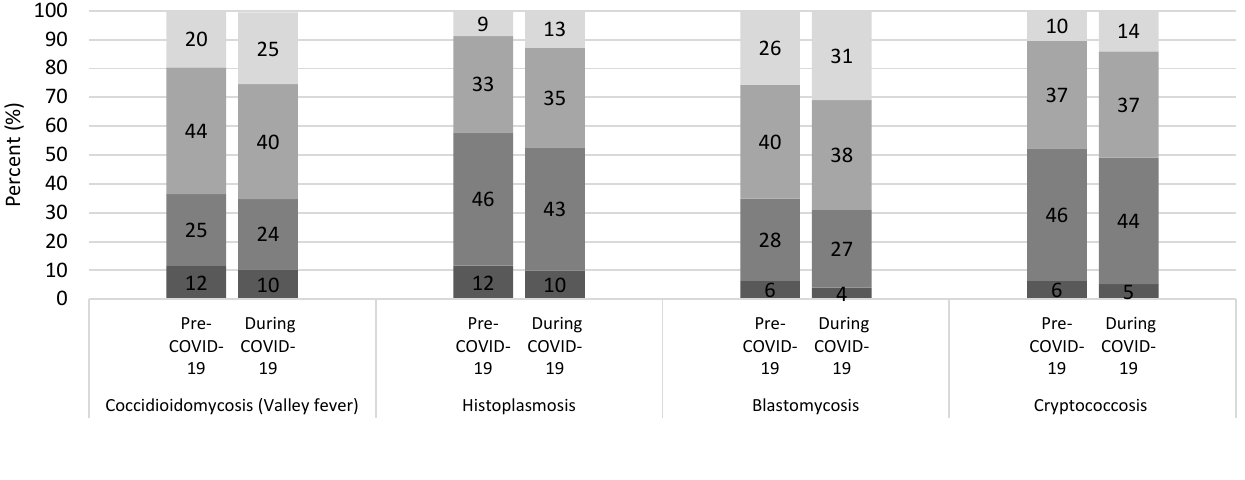
Figure 1. Infectious disease physicians’ reported testing frequency for coccidioidomycosis, histoplasmosis, blastomycosis, and cryptococcosis among patients with signs and symptoms of community-acquired pneumonia, before and during the COVID-19 pandemic, United States.